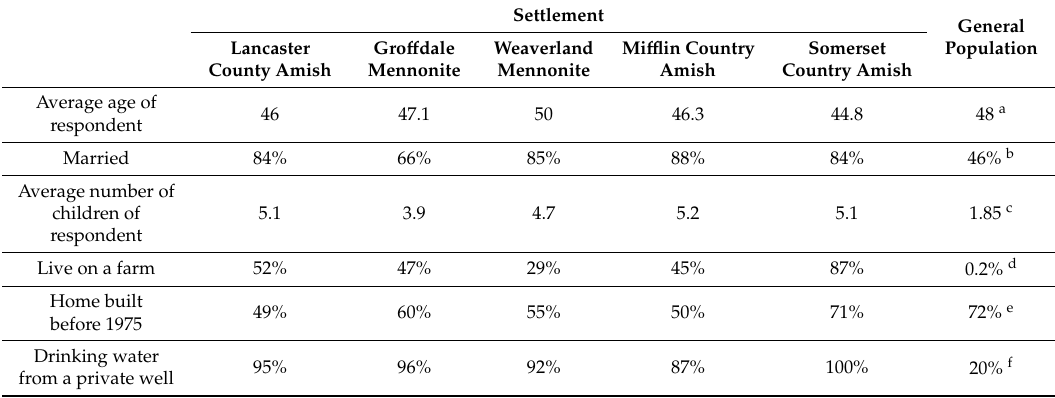
Table 2. Demographic characteristics of 5 Pennsylvania Plain communities and the general Pennsylvania